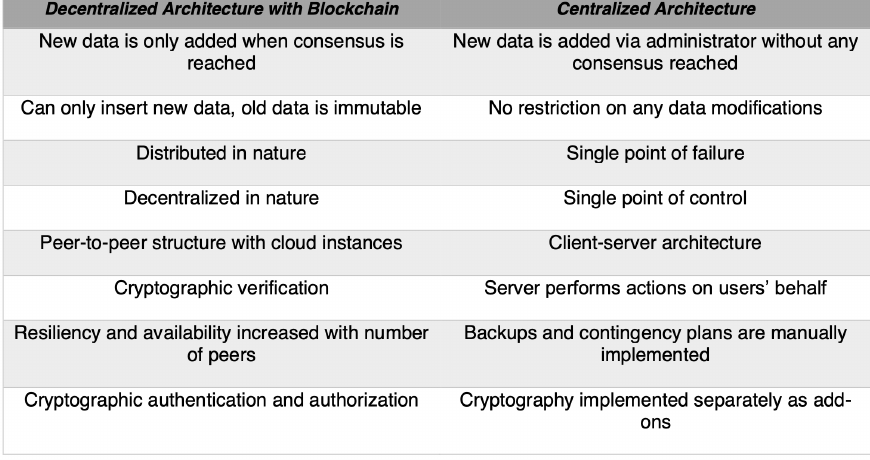
Figure 1. Comparison of Decentralized and Centralized